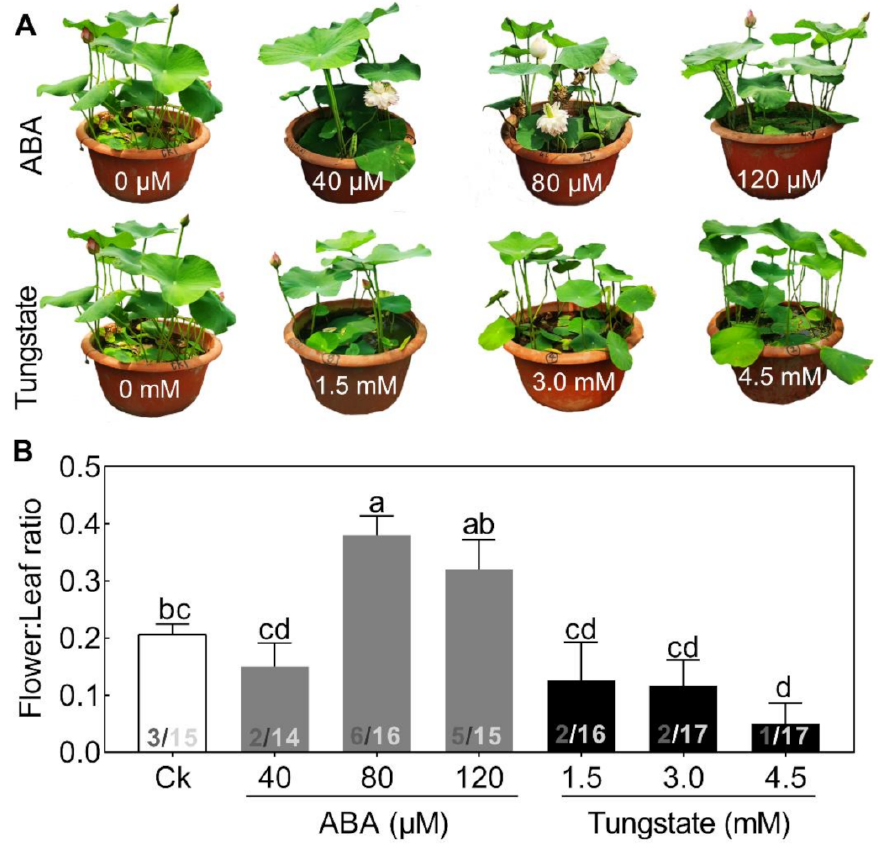
Figure 4. Effects of different concentrations of abscisic acid (ABA) and tungstate on lotus plants. Two-month-old lotus seedlings were used for ABA and tungstate treatments. The representative picture was taken when plants were treated for 9 days ( A ) and the flower:leaf ratio ( B ) was analyzed. The numbers on the bottom of each column represent the corresponding number of flowers and leaves of the flower:leaf ratio. Values are the means ± SE of three independent experiments with at least three replicates for each.Bars marked with different letters are significantly different from each oher at p < 0.05, according to Tukey’s multiple